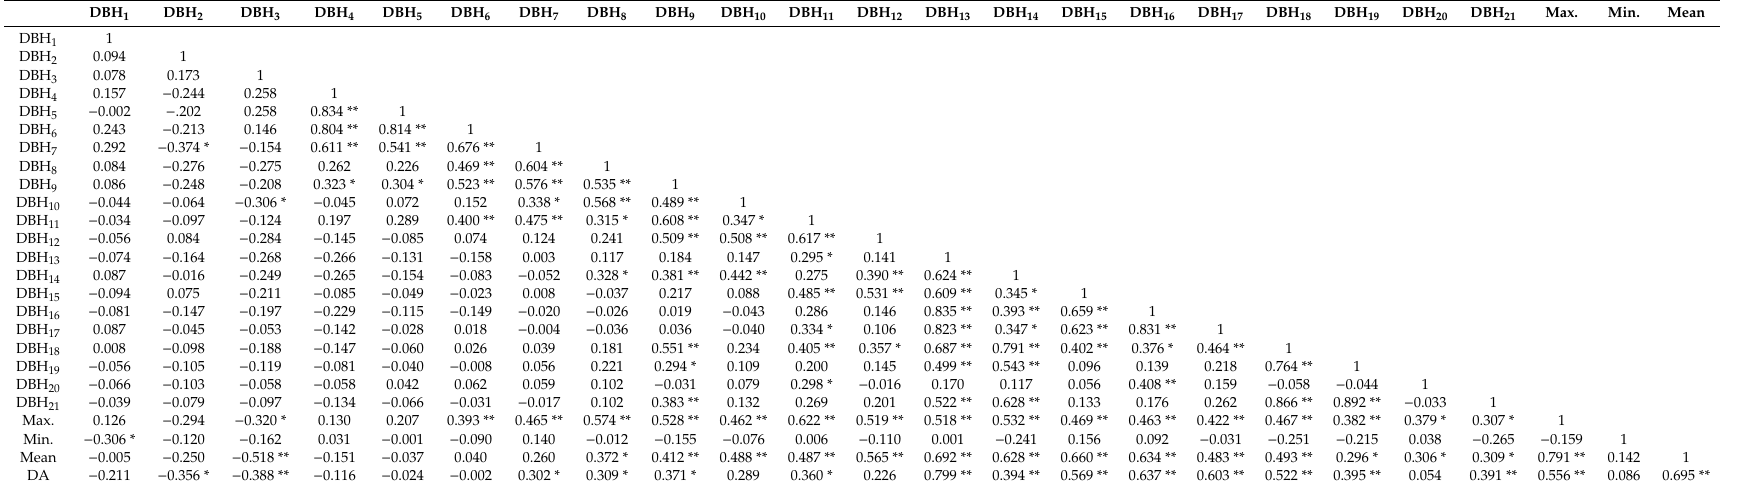
Pearson correlation analysis of diameter at breast height (DBH) classification and deviation of individual-tree segmentation measured in two-centimeter